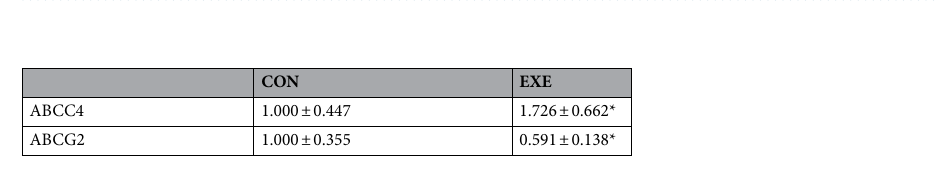
Table 7. ABCC4 and ABCG2 protein expression of rat’s kidney. *Significantly different from CON ( p < 0.05).